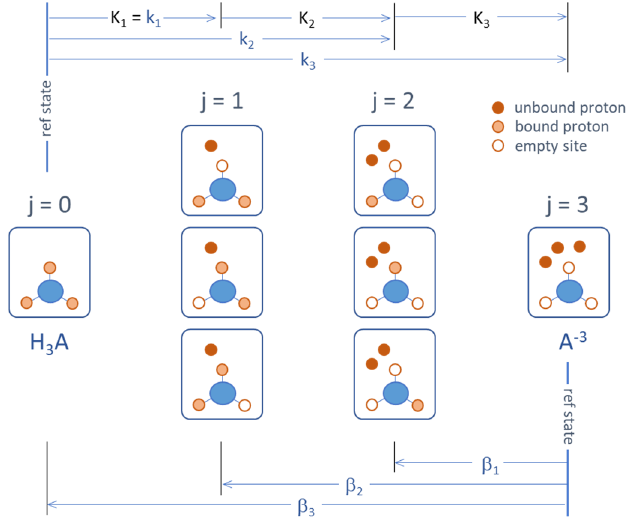
Figure 21. Micro- and macrostates of a triprotic acid and the corresponding (cumulative) equilibrium